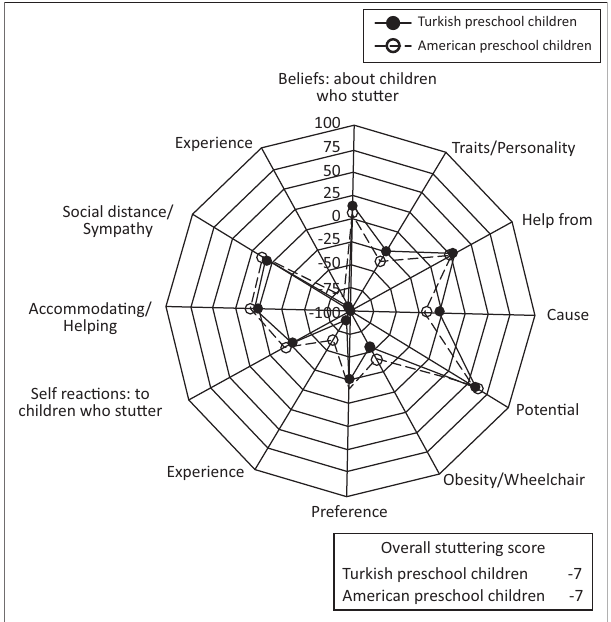
FIGURE 1: Comparison of mean values for POSHA–S/Child components, sub- scores, and overall stuttering scores for the United States and Turkish